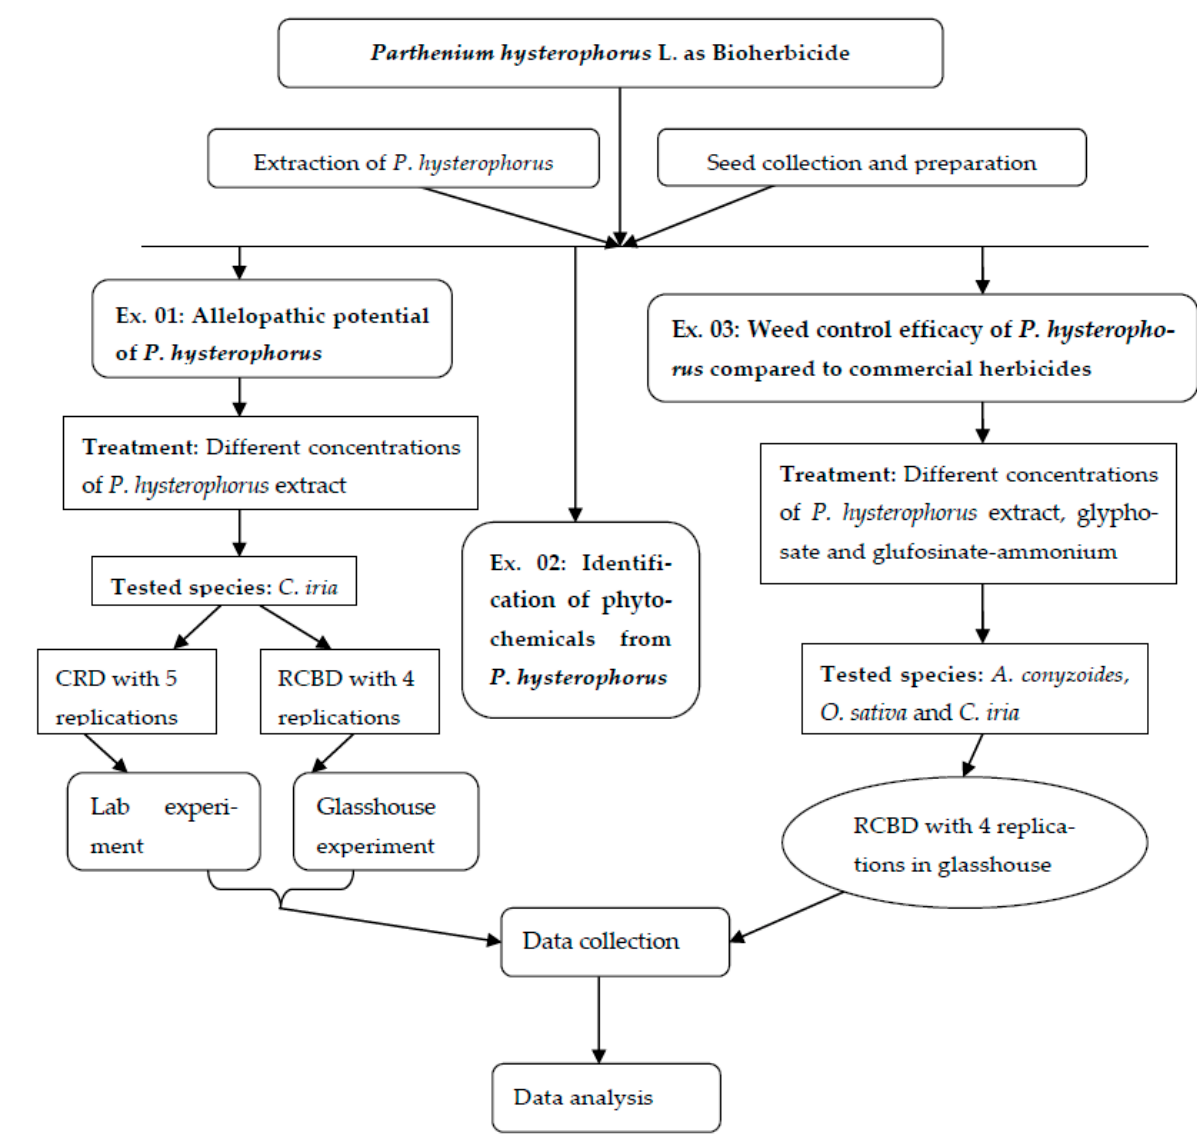
Figure 5. Graphical scheme of study design.